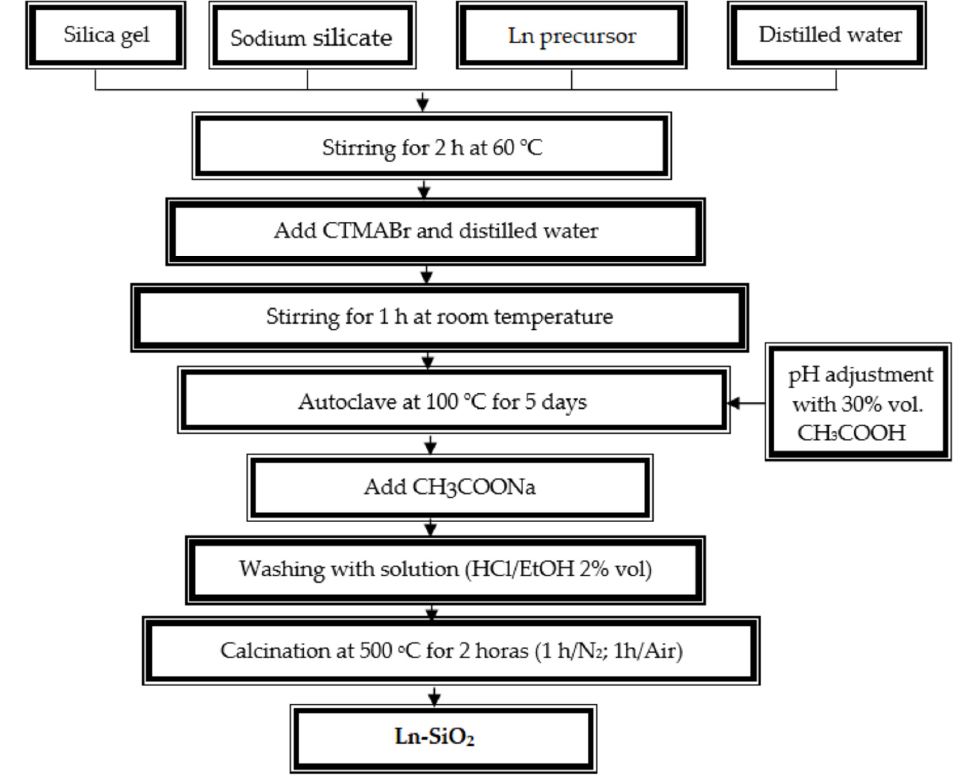
Figure 1. Flowchart showing the steps in the hydrothermal synthesis of Ln–SiO 2 materials where Ln = La, Ce, Pr, Nd, Eu, Gd, Dy, Yb, Lu.